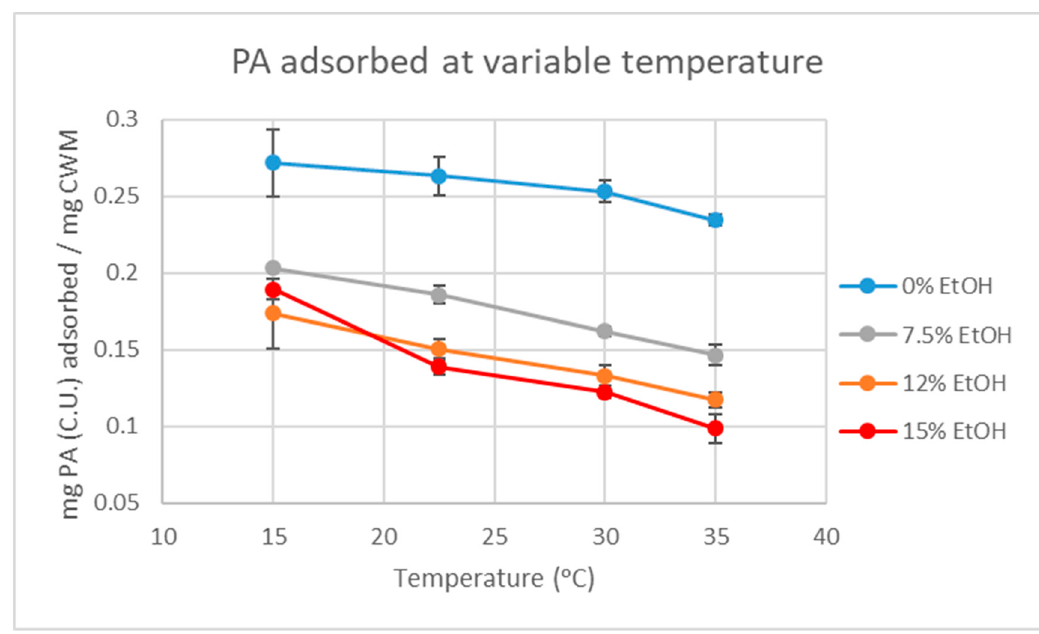
Figure 2. PA adsorption in four distinct model wine solutions over varying temperature conditions ( n = 3 for each data point).